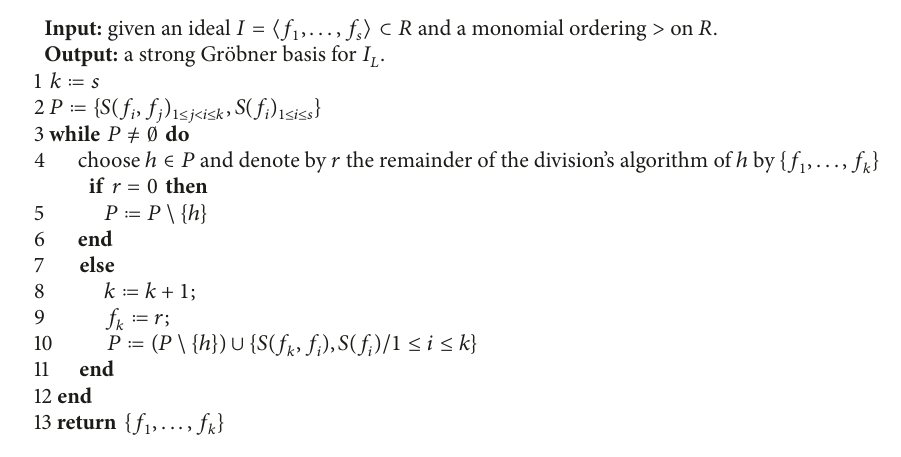
Algorithm 2: Buchberger’s